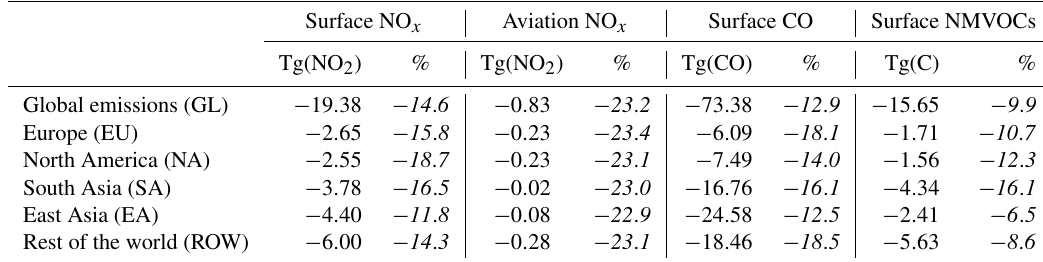
Table 1. Changes in global and regional annual anthropogenic emissions from 2019 to 2020 (in Tg and as a percentage of 2019) assumed to be associated with COVID-19 lockdowns. The rest of the world (ROW) is defined as everywhere apart from the four HTAP regions. Derived from data in Lamboll et al.